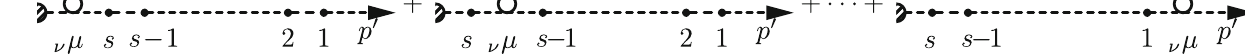
Fig. 8 The diagrams with only q = ν vertices circled that belong to set III